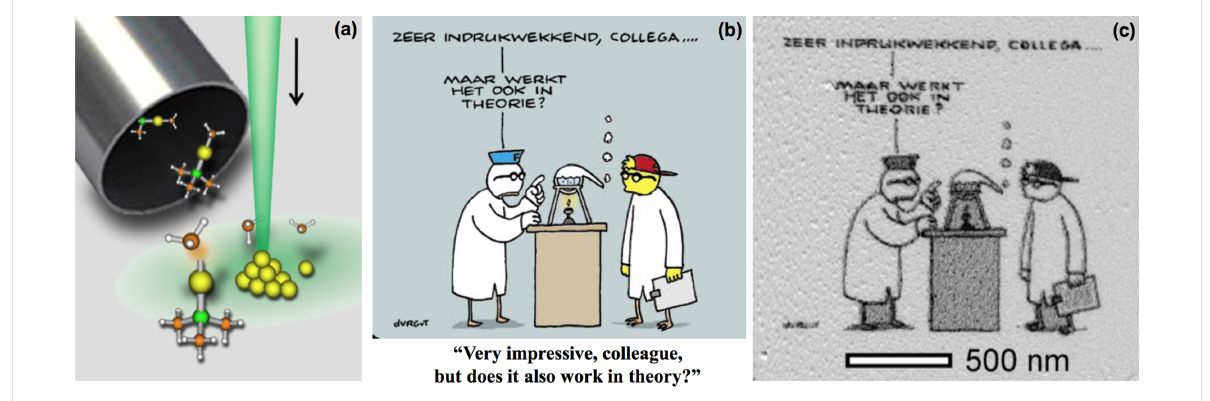
Figure 1: (a) A schematic drawing of the focused electron beam induced deposition. (b) A Fokke and Sukke cartoon. Reproduced with permission of Reid, Geleijnse & Van Tol. (c) The cartoon in panel (b) written on an electron-transparent membrane, using a scanning transmission electron micro- scope and W(CO) 6 as precursor. The pattern consists of tungsten-containing dots of about 3 nm in